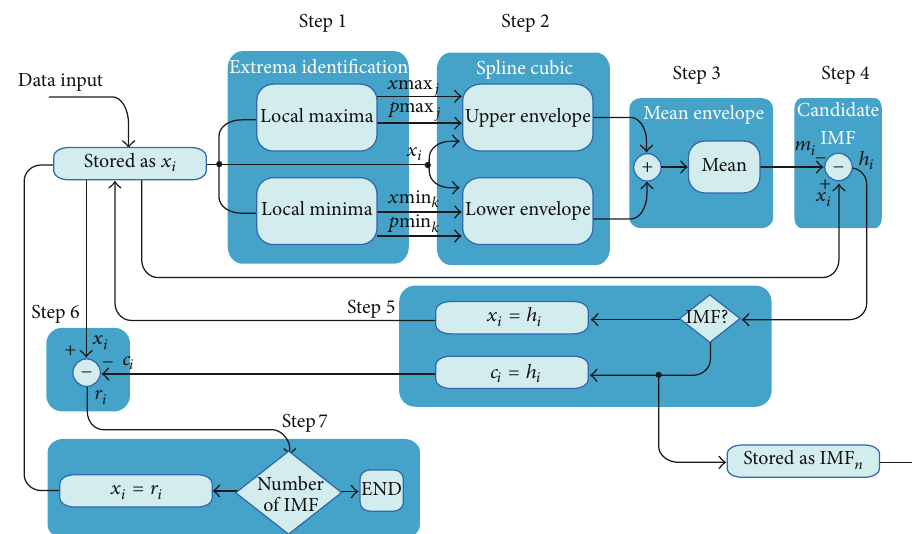
Figure 8: Block diagram of the EMD approach proposed.